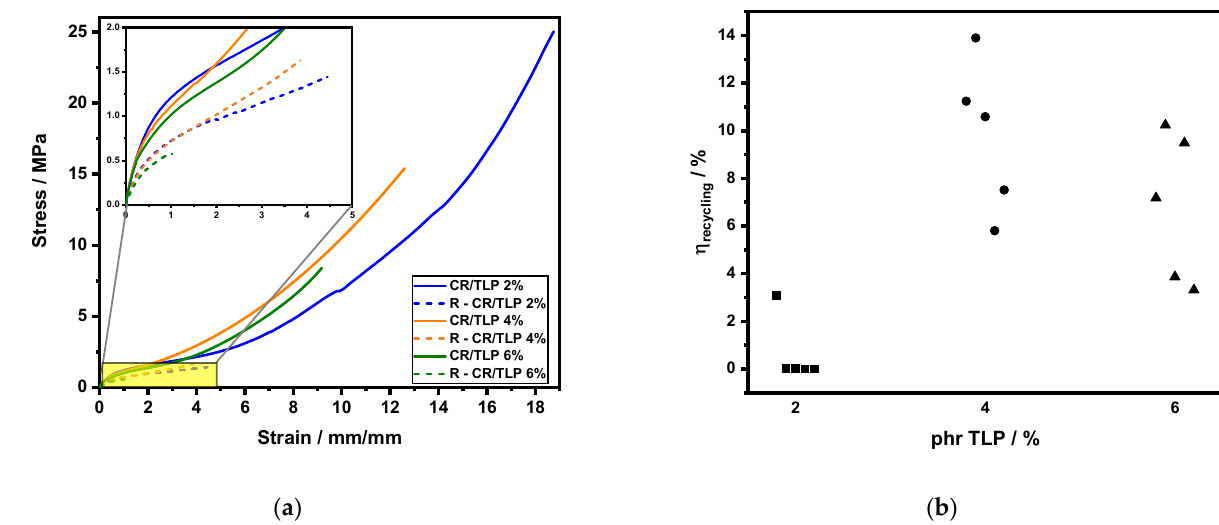
Figure 7. ( a ) Tensile test comparison between recycled compounds and cured compounds; ( b ) Recycling efficiency com- parison between five repeats for each concentration of TLP.